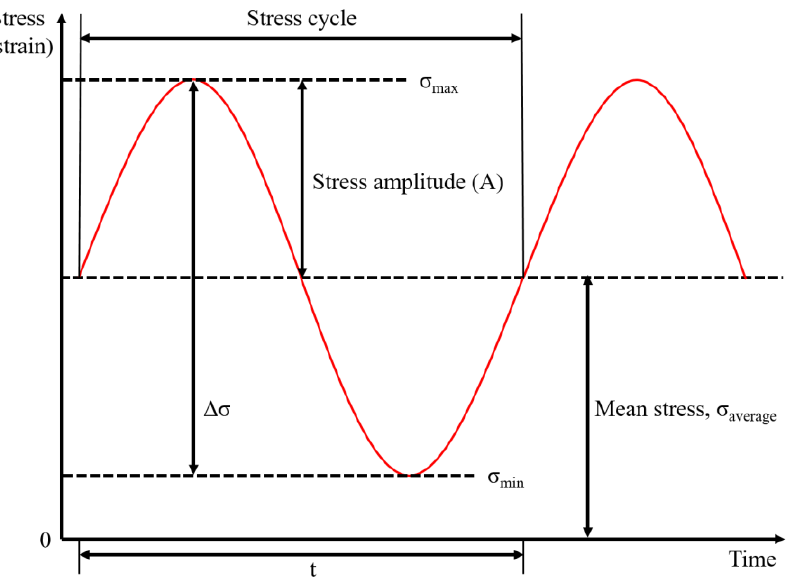
Figure 6. Scheme of the applied sinusoidal form during fatigue test